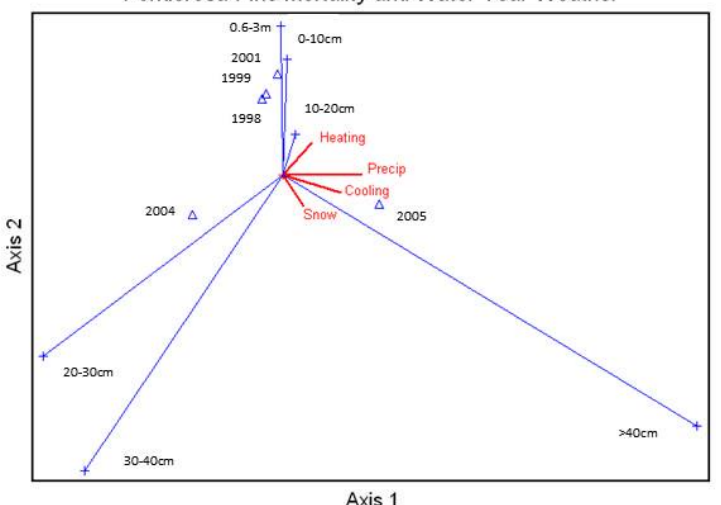
Figure 7. Canonical Correspondence Analysis Ordination for average percent mortality of all ponderosa pine size classes measured in the study area by year and correlated with the water year snow and rainfall and the number of heating and cooling degree days. Snow = Snow accumulation, Cooling = lower temperatures, Heating = warmer temperatures, Precip = precipitation amounts. xx ‐ xxm = height class, xx ‐ xxcm = diameter class.